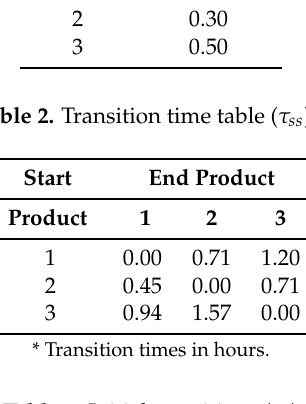
Table 3. Initial transitions ( τ θ